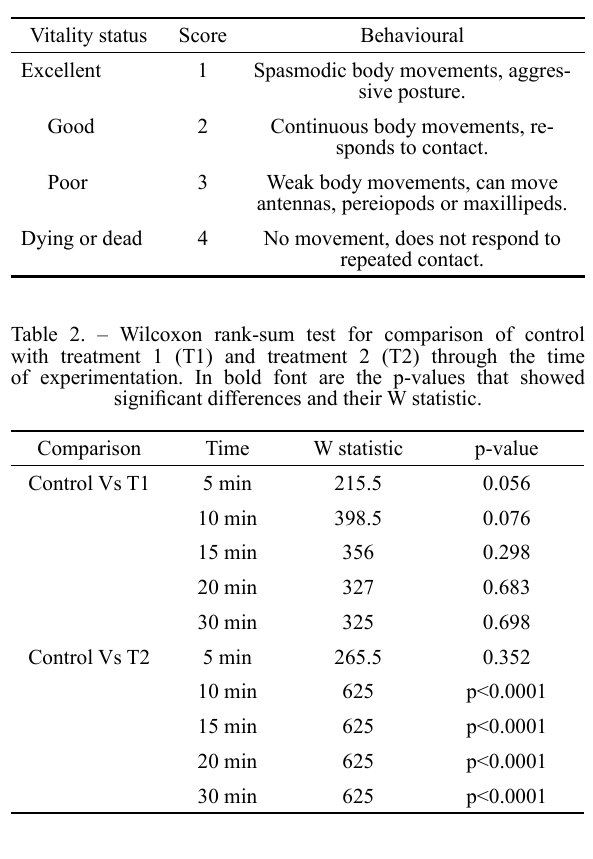
Table 1. – Criteria of the Categorical Vitality Assessment (CVA) for N. norvegicus , following García-de-Vinuesa et al. (2020).